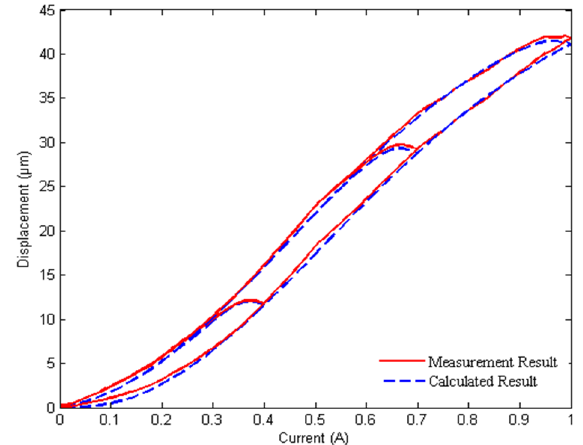
( d ) Figure 7. Comparison of simulation results and experimental results: ( a ) Measurement result and Genetic Algorithm; ( b ) Measurement result and Particle Swarm Optimization; ( c ) Measurement Re- sult and Differential Evolution; ( d ) the time of Genetic Algorithm, Particle Swarm Optimization, and Differential Evolution. When the current changes from 0 A to 1 A with the step of 0.01 A, the average relative errors are obtained, 4.87%, 5.02%, 5.24% and 5.16%, respectively, by comparing simulation results calculated from the four groups of identified parameters available in Table 3 with experimental results. In three current ranges such as 0–0.4 A, 0–0.7 A and 0–1 A, the output displacements of the GMA are calculated from the identified parameter with the mini- mum relative error. As shown in Figure 8, the calculated results are basically consistent with the measurement results. In addition, under the action of twelve different current values which are selected randomly, the displacements are calculated by using the iden- tified parameters of the DE. The comparison results between actual values and calculated